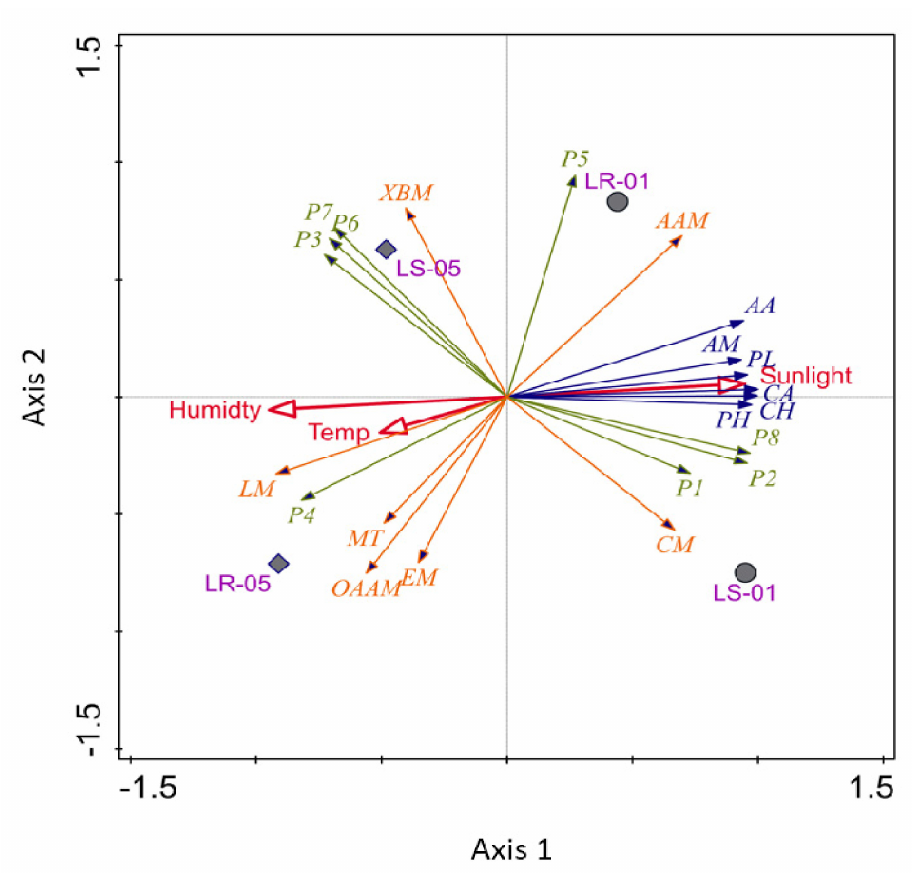
Figure 7. Principle component analysis of major carbon sources (AA, amino acids; AM, amines; PL, polymers; CA, carboxylic acid; CH, carbohydrates; PH, phenols) with predicted KEGG pathways (XBM, Xenobiotic biodegradation and metabolisms; AAM, amino acid metabolism; CM, carbohydrate metabolism; LM, lipid metabolism; EM, energy metabolism; OAAM, other amino acid metabolism; MT, membrane transport), including major bacterial phylum (P1, Planctomycetes; P2, Proteobacteria; P3, Acidobacteria; P4, Actinobacteria; P5, Nitrospirae; P6, Chloroflexi, P7, Gemmatimonadetes; P8, Cyanobacteria) against the environmental